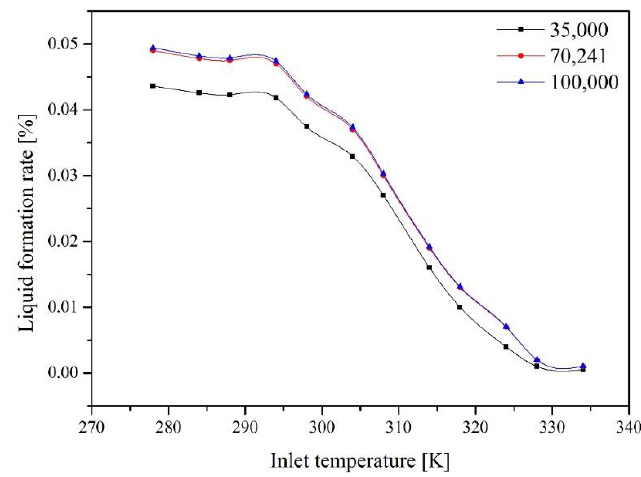
Figure 3. Simulation results of liquid generation rate corresponding to different cells.